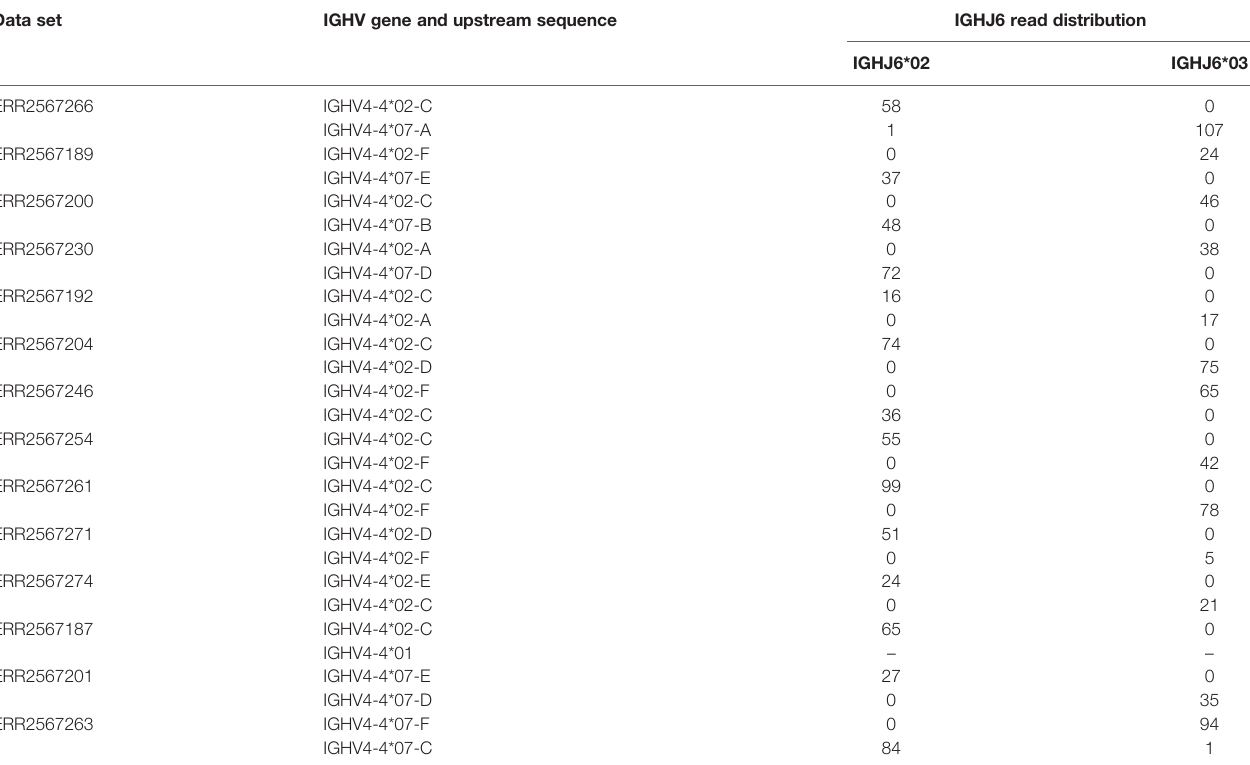
TABLE 1 | Haplotyping to support the validity of diverse 5 ’ UTR-leader sequence of allele IGHV4-4*02 and IGHV4-4*07. Data set IGHV gene and upstream